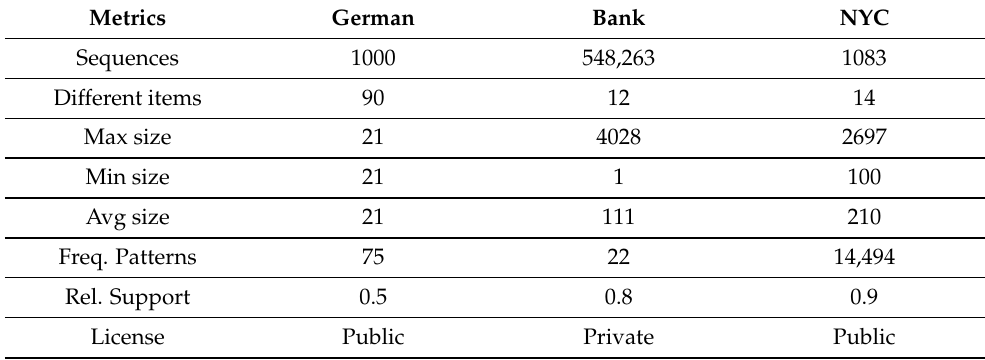
Table 1. Main characteristics of sequences’